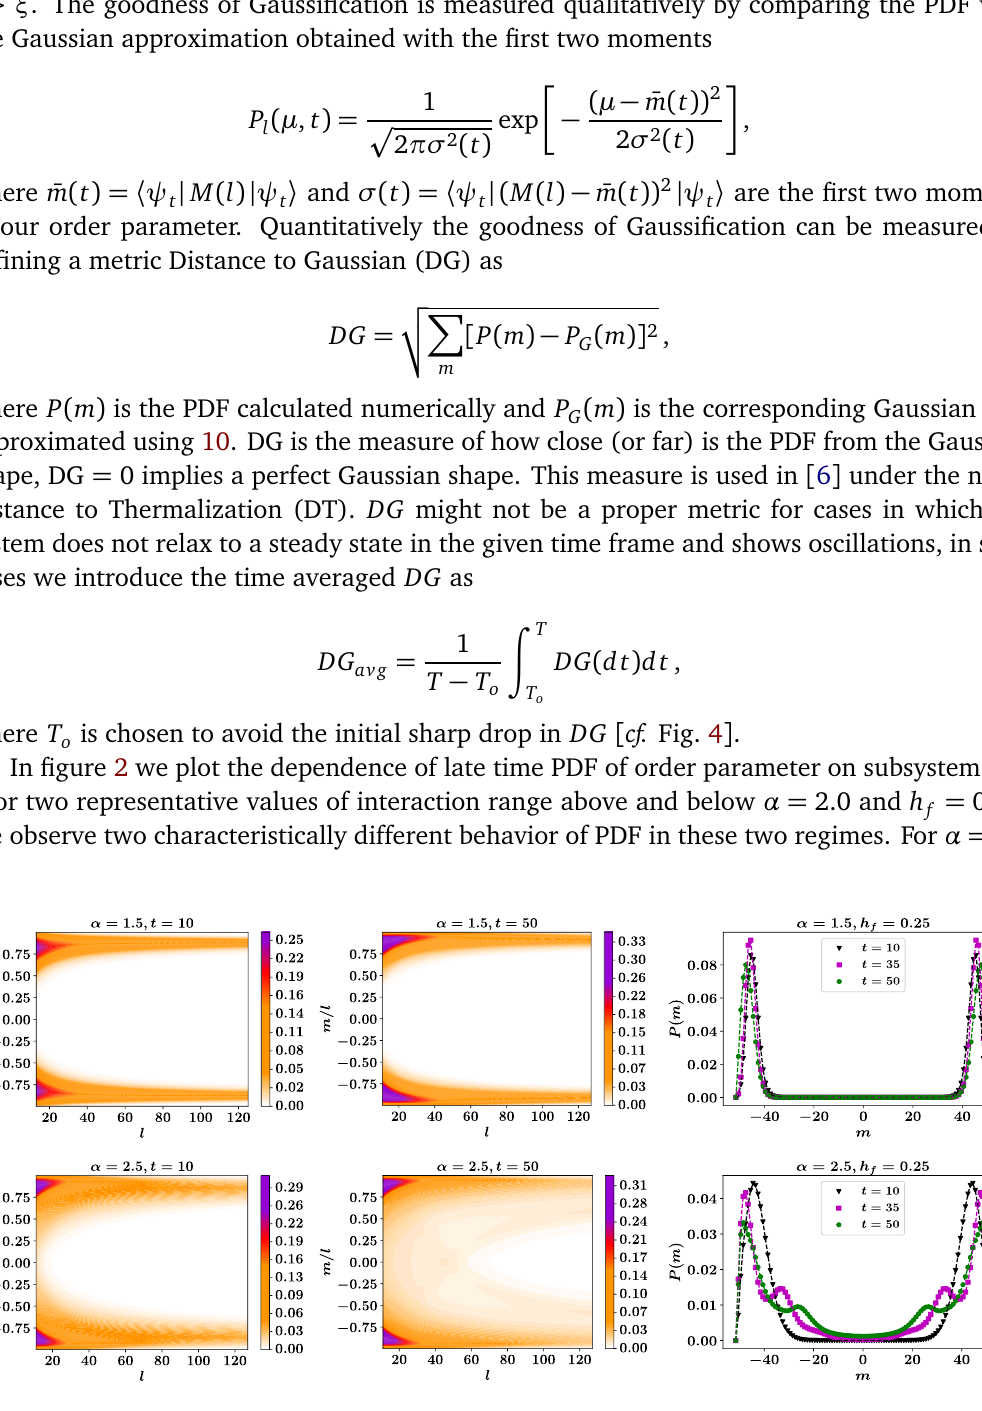
Figure 3: PDF of subsystem magnetization for α ∈ { 1.5,2.5 } , h second rows respectively) at different time scales after the quantum quench. The first two columns shows the contour plot of the rescaled PDF as a function of subsystem size at times t ∈ { 10,50 } . The last column shows the PDF at times t ∈ { 10,35,50 } and subsystem size l =